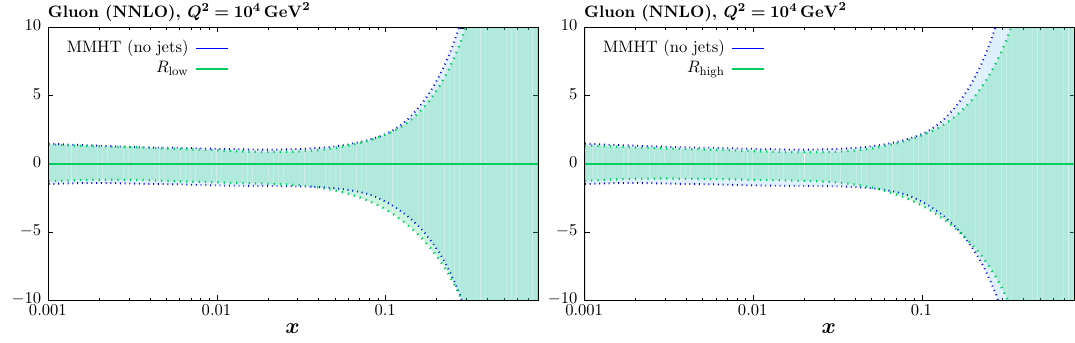
Fig. 12 The impact on the gluon PDF errors at NNLO of including the ATLAS [23] and CMS [24] 7 TeV jet data in the global fit. The percentage errors at 68% C.L. are shown, with the result of the baseline